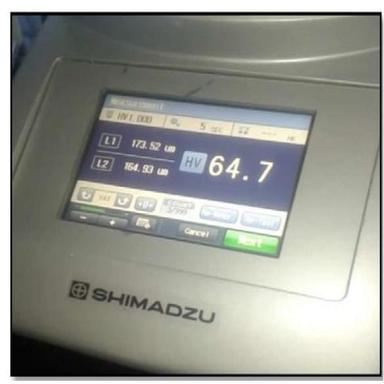
Micro Vickers hardness Readings.